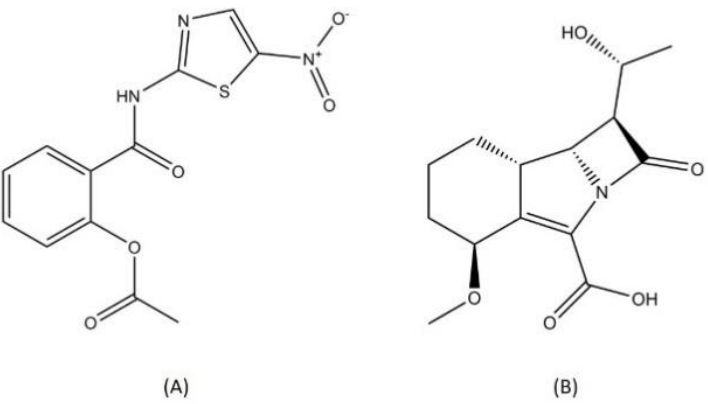
Figure 9. Structure of ( A ) nitazoxanide and ( B ) sanfetrinem.